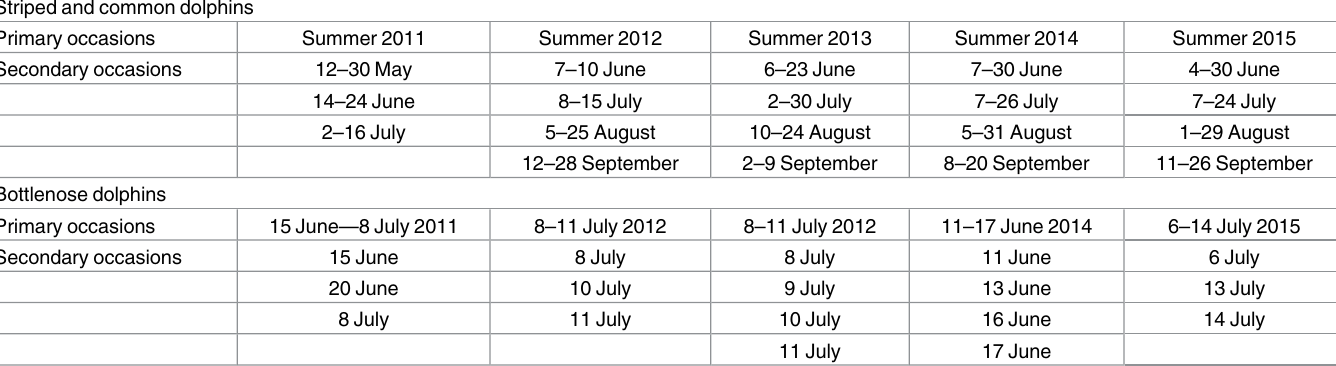
Table 1. Primary and secondary capture occasions for the two capture matrices(striped and common dolphins, and bottlenose dolphins). All samplingdays with encounters of the three species are listed in S1 and S2 Tables. Striped and common